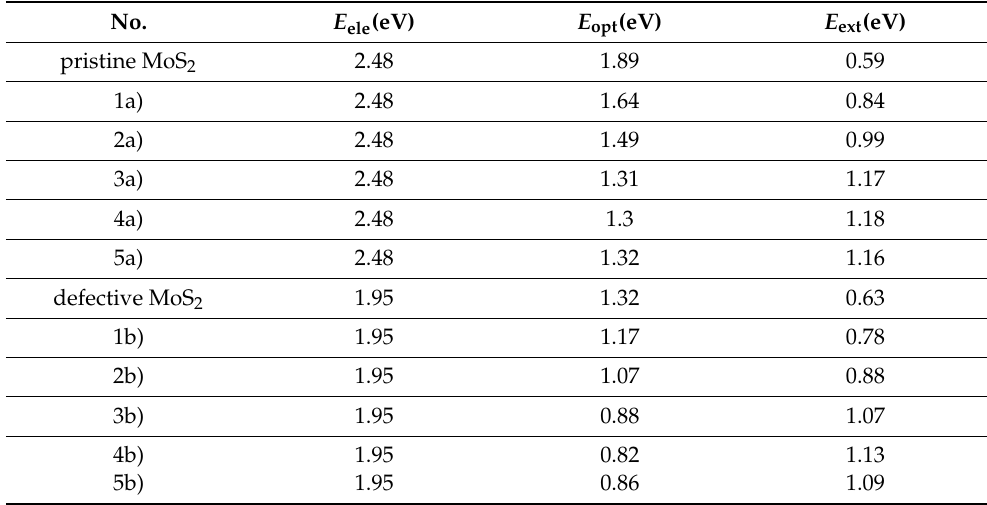
Figure 5. The optical absorption spectra for (H 2 O) n ( n = 1–5) on the pristine and defective MoS 2 monolayers simulated with the DFT- app G 0 W 0 -BSE method. The dark solid and dashed lines indicate the optical and electronic band gap, respectively. Excitonic binding energies are shown as well. The notations of A, B and C correspond to the optical absorption peaks. The notations of ( a ) and ( b ) correspond to the pristine and defective surfaces, respectively; numbers 1–5 correspond to the number of water molecules on the surface. Table 2. The QP electronic band gap ( E ele ), optical band gap ( E opt ), and excitonic binding energy ( E ext ) for (H 2 O) n ( n =1-5) on the pristine and defective MoS 2 monolayers. No.